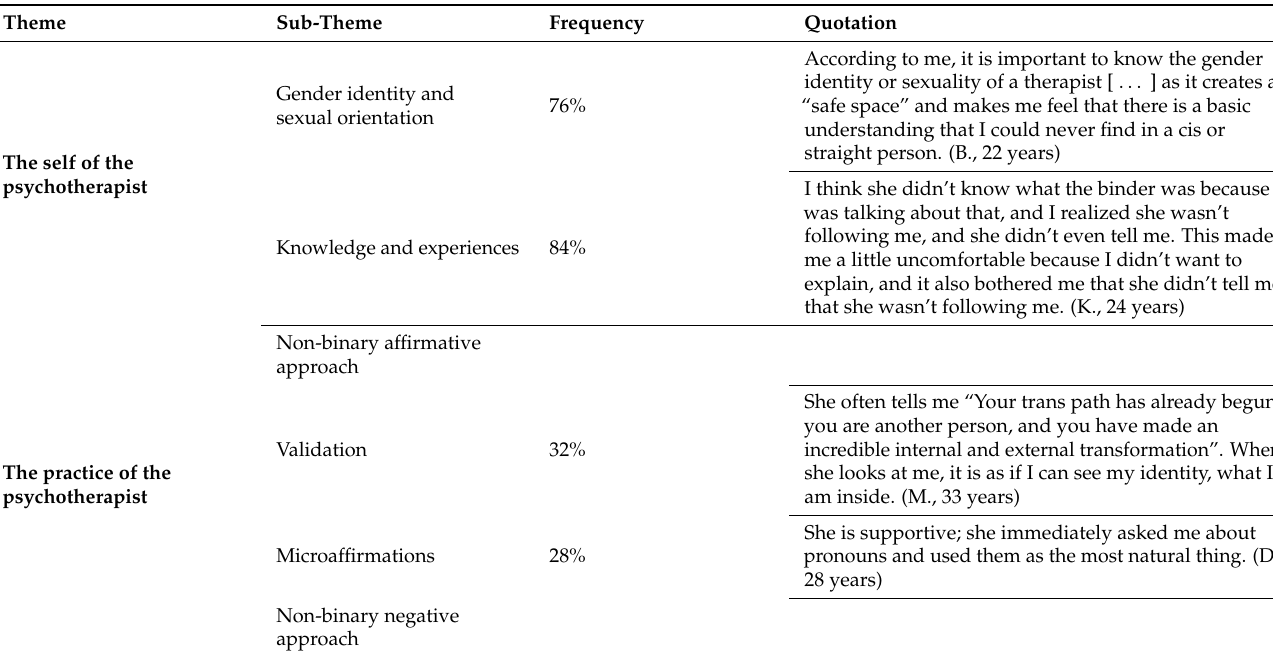
Table 1. Thematic structure, representative quotations, and